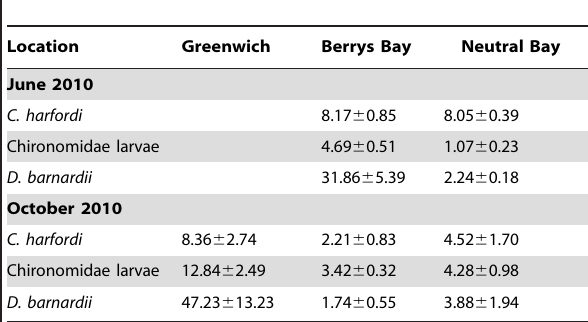
Table 1. Densities of Cirolana harfordi (mean 6 S.E. number of individuals in 100 ml of oyster-bed) compared with densities of the most abundant arthropods (Chironomidae larvae and Dynoides barnardii ) at Greenwich, Berrys Bay and Neutral Bay in June and October 2010. Greenwich was not sampled in June 2010 (see